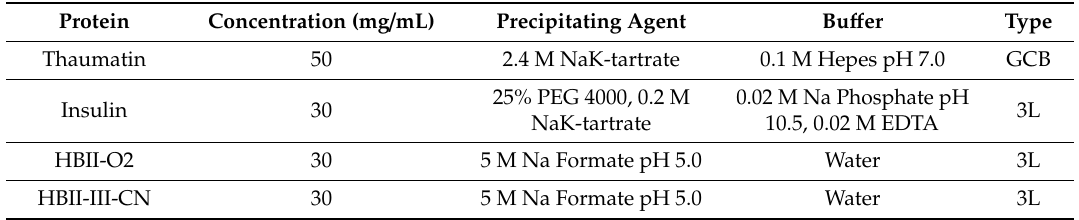
Table 1. Summary of the crystallization conditions. For ground experiments 0.1%–0.3% (w / v) agarose was added to the protein